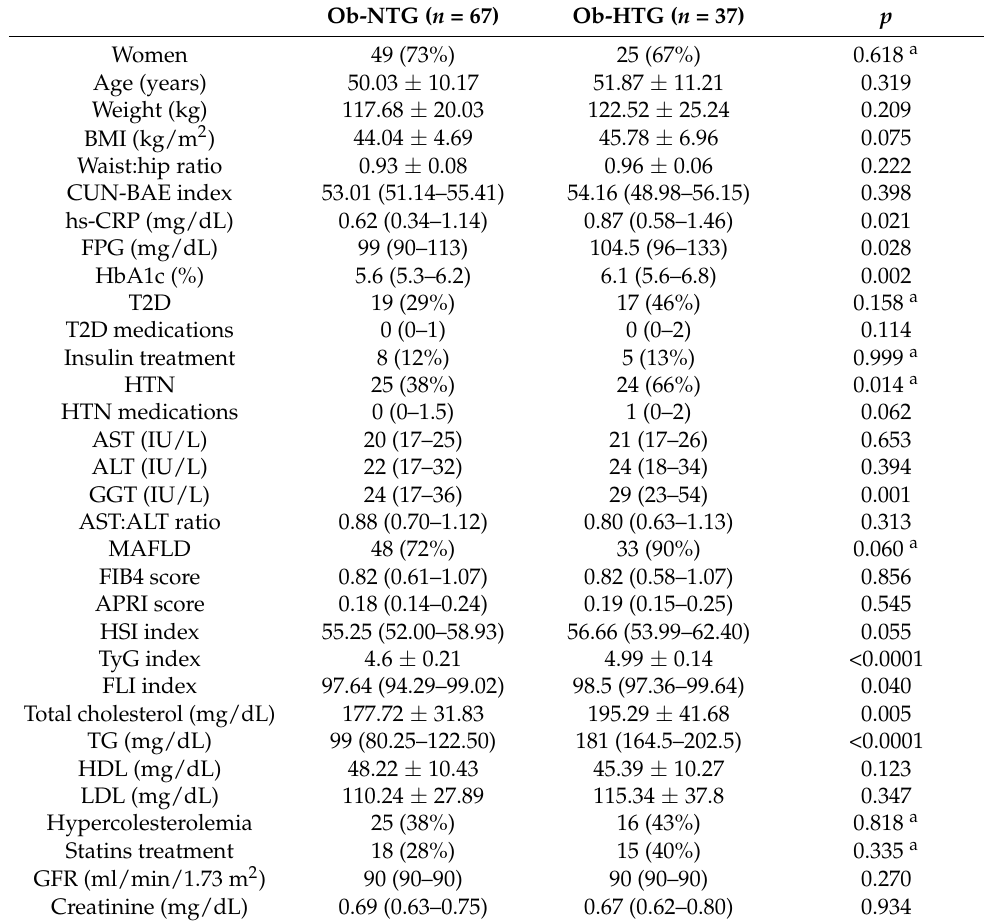
Table 1. Clinical characteristics of the study